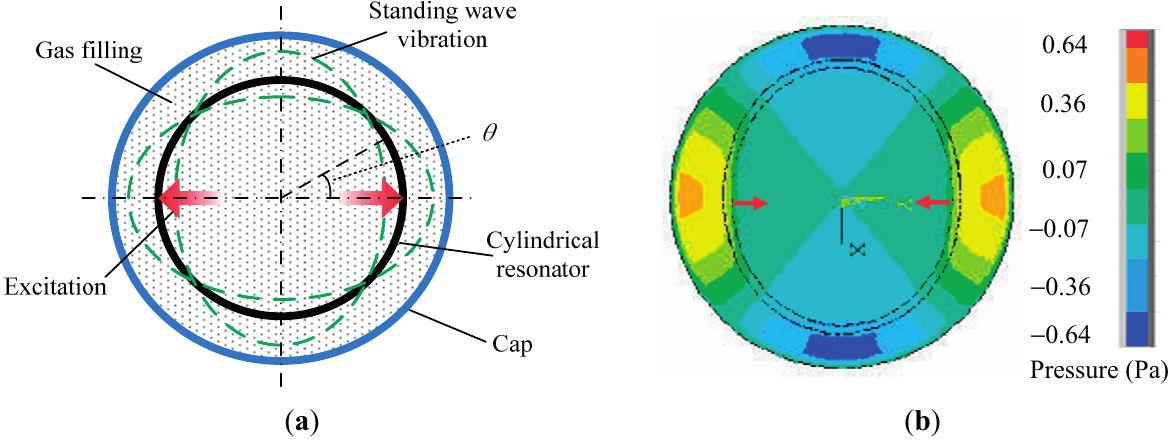
Figure 2. ( a ) Cylindrical resonator in a cap; ( b ) Acoustic pressure contour of the vibratory cylinder